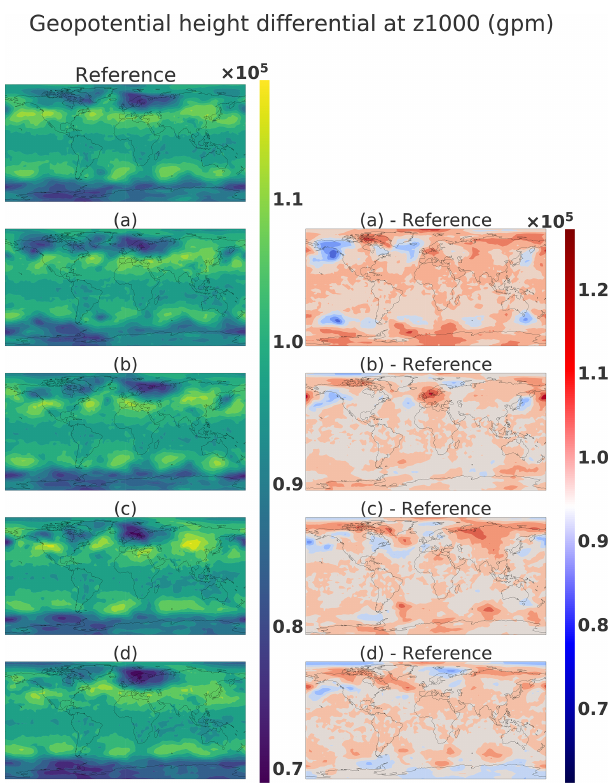
Figure 29. Geopotential height: the first column reference corre- sponds to G(A) , and panels (a–d) correspond to G(A + (cid:15) i ) and the second column G(A) − G(A + (cid:15) i )